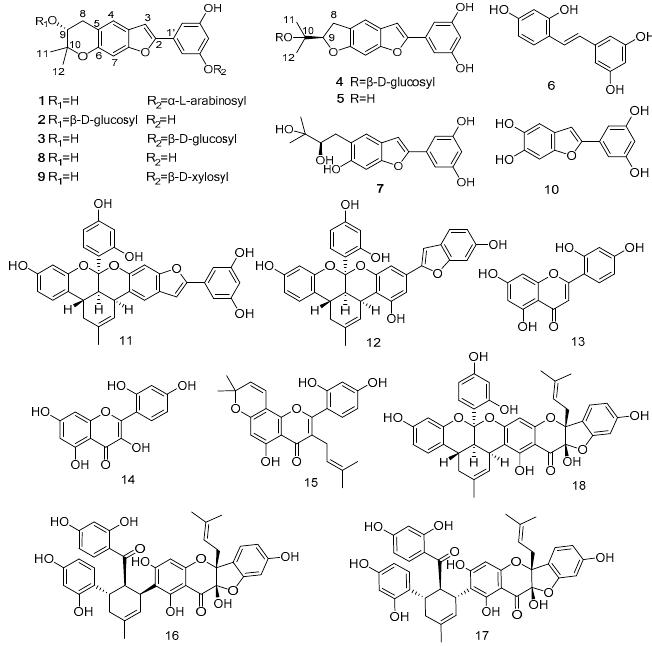
Figure 1. Structures of isolated compounds from Cortex Mori Radicis.